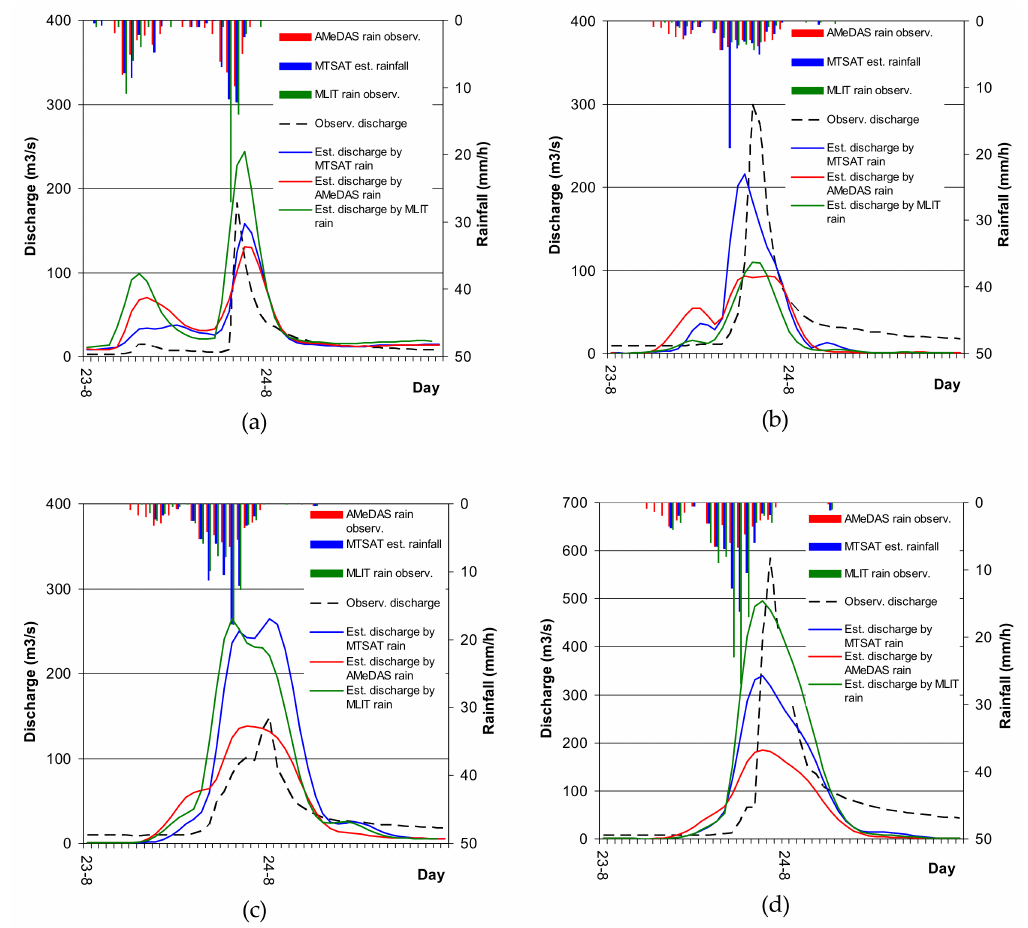
Figure 6. Peak discharge during a heavy rainfall event on 23–24 August 2010 at the catchment outlets of ( a ) Shirai; ( b ) Upper Ishikari; ( c ) Beiegawa and ( d ) Bebetsugawa river.